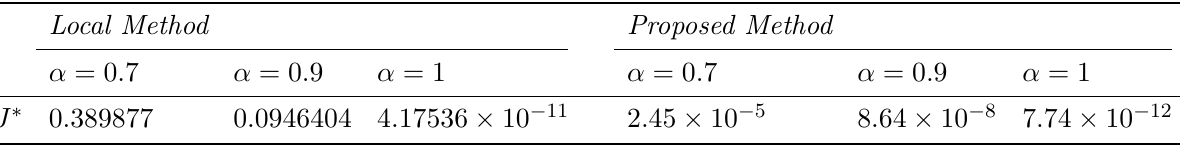
Table 1. The value of J ∗ for Example 1 ( m = 7 and different α ).